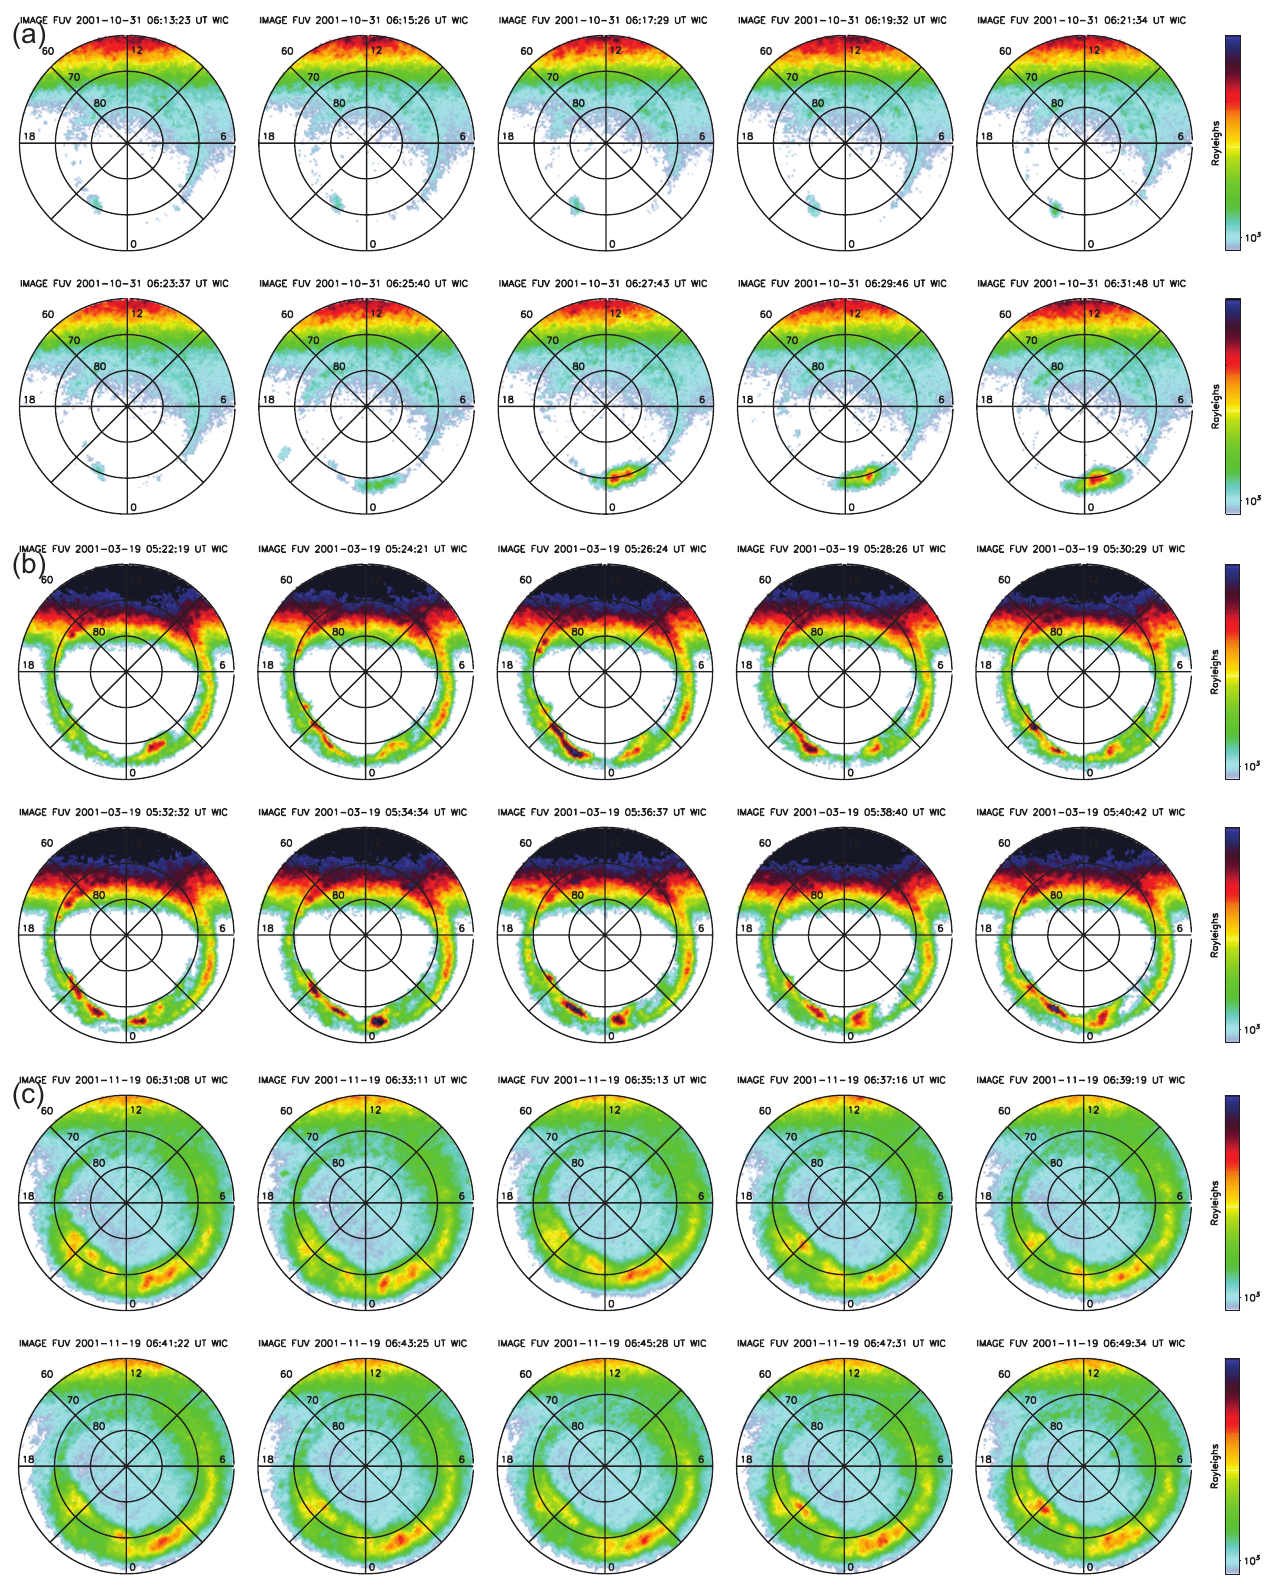
Figure 4. Individual auroral images for illustrating the type of activity observed for the three days, 31 October ( a ), 19 March ( b ) and 19 November 2001 ( c ) that cover the period of low-energy ion observations. The intensity of the aurora is shown in